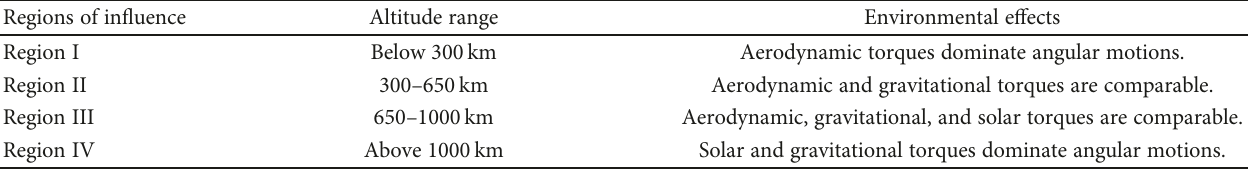
Table 1: Environmental torque general regions of in fl uence (adapted to metric units from Schrello [19]). Regions of in fl